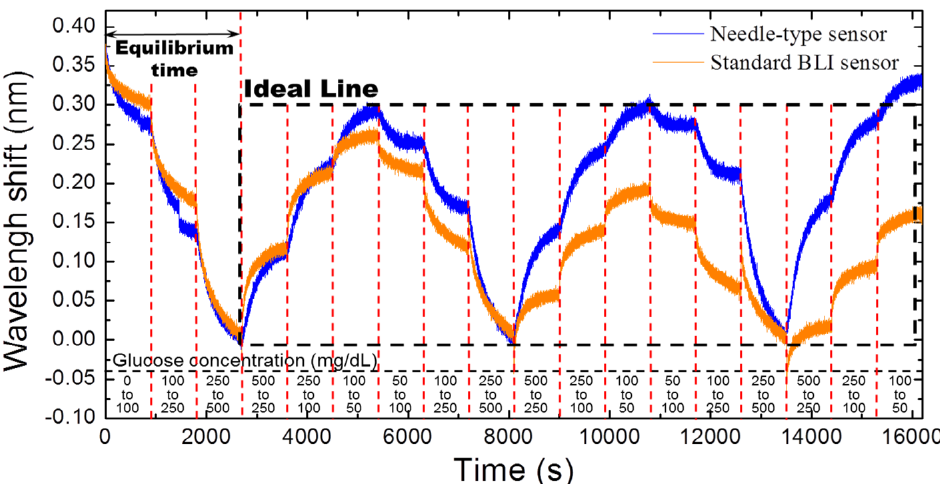
Figure 3. Comparison of the needle-type sensor with the standard bio-layer interference (BLI) sensor. Nearly identical profiles were observed when tested with a wide range of glucose concentrations. The profiles indicate that the reproducibility of the needle-type sensor is more stable than the standard BLI sensor.